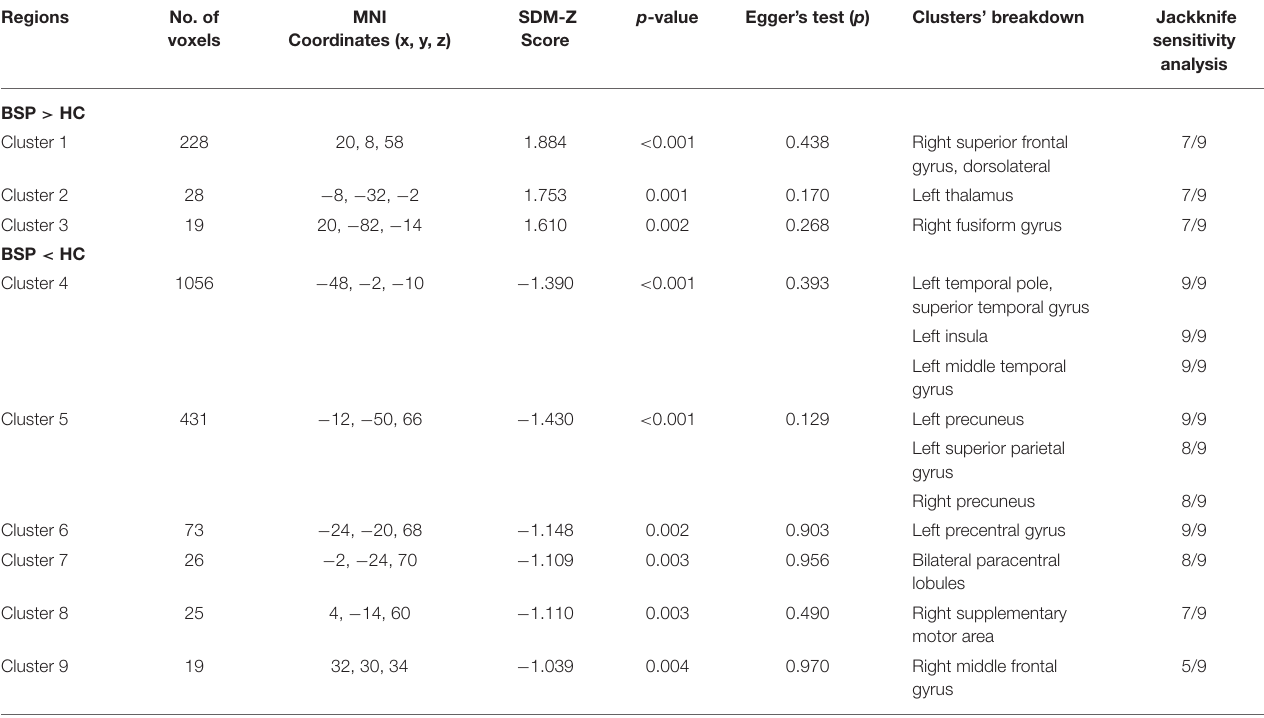
TABLE 4 | Clusters of functional alterations in patients with idiopathic blepharospasm compared with healthy controls. p -value Egger’s test ( p Regions No. of MNI SDM-Z voxels Coordinates (x, y, z) Score